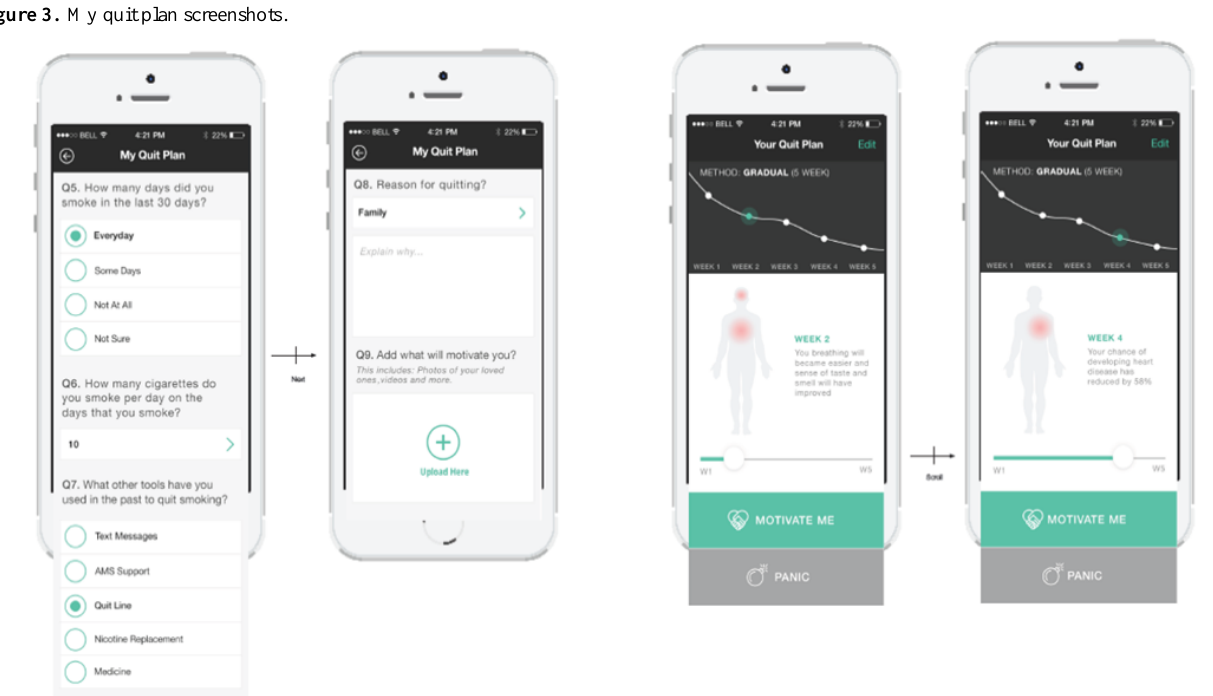
Figure 3. My quit plan